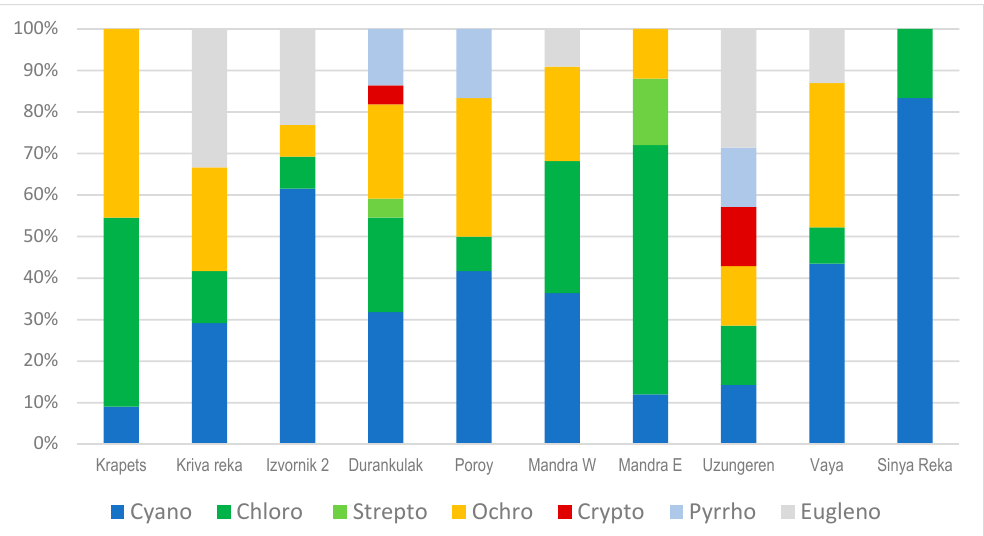
Figure 3. Relative contribution of different taxonomic groups to the phytoplankton biodiversity according to the number of species, obtained by light microscopy, in the studied Bulgarian water bodies (August 2019). Legend: Mandra W—western part of the reservoir Mandra, Mandra E—eastern part of the reservoir Mandra; Cyano—Cyanoprokaryota, Chloro—Chlorophyta, Strepto—Streptophyta, Ochro—Ochrophyta, Crypto—Cryptophyta, Pyrrho—Pyrrhophyta and Eugleno—